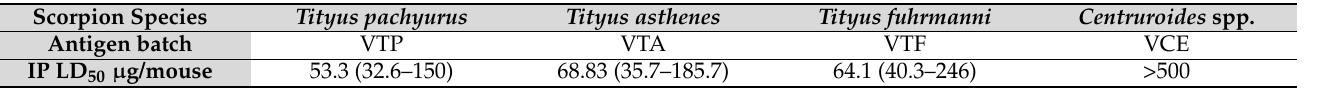
Table 1. Scorpions venoms LD 50 . Median lethal doses (LD 50 ) of each scorpion venom batch, deter- mined using intraperitoneal (I.P.) injection route, with 95% confidence intervals and calculated by non-linear regression. L.D.: Lethal